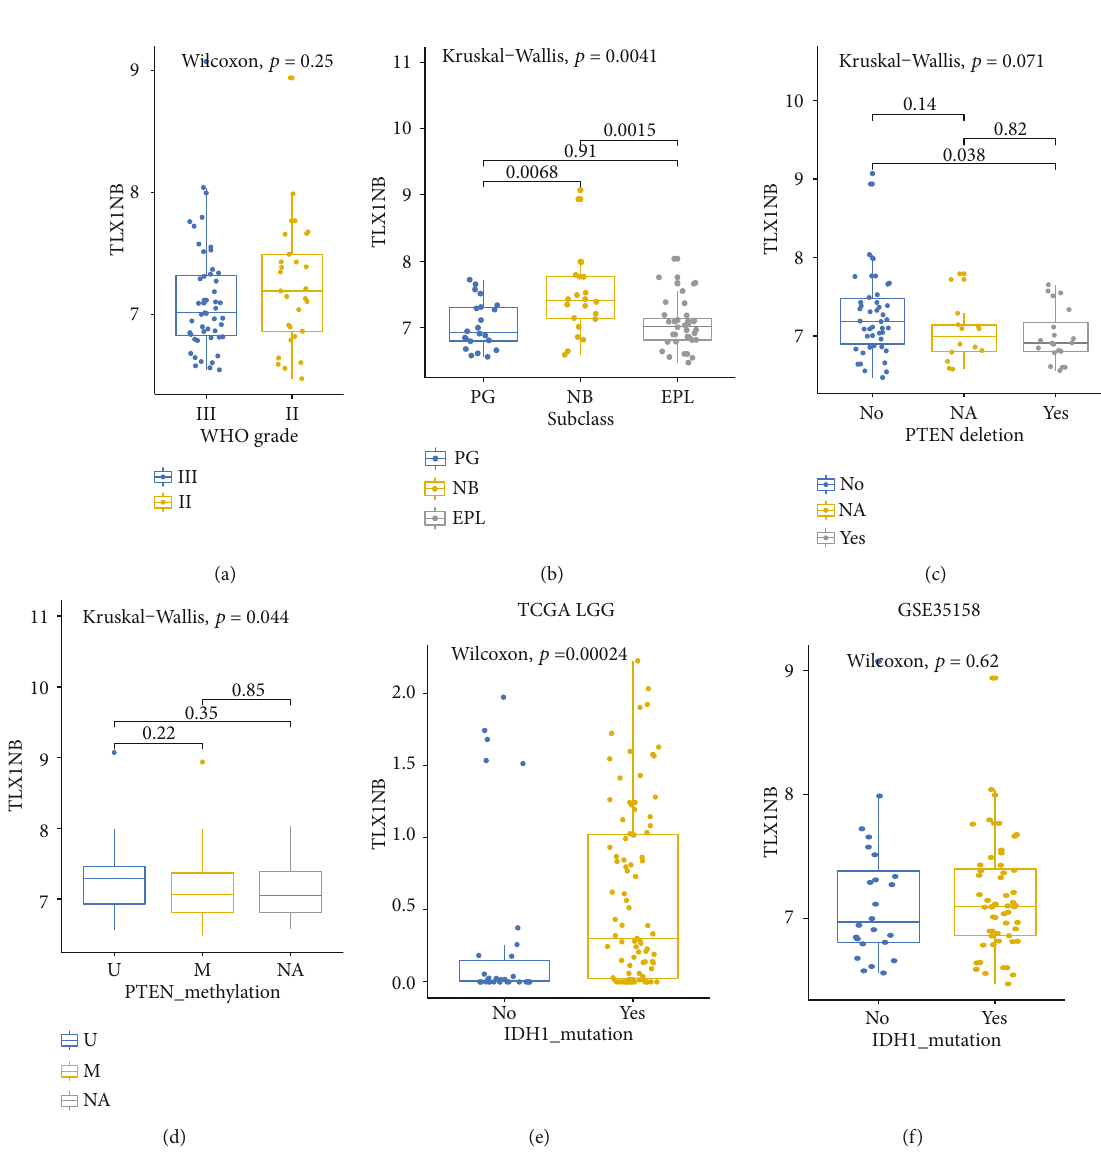
Figure 4: TLX1NB distribution in di ff erent subsets. (a) TLX1NB distribution between grade II and III LGG. A p value < 0.05 was selected as the signi fi cance threshold. (b) High expression of TLX1NB in the NB group compared with PG and EPL. A p value < 0.05 was selected as the signi fi cance threshold. NB: neuroblastic; PG: preglioblastoma; EPL: early progenitor-like. (c) Low expression of TLX1NB in the PTEN deletion group. A p value < 0.05 was selected as the signi fi cance threshold. (d) No di ff erence for TLX1NB between PTEN methylation and unmethylation group. A p value < 0.05 was selected as the signi fi cance threshold. (e) High expression of TLX1NB in the IDH1 mutation group in the TCGA dataset. A p value < 0.05 was selected as the signi fi cance threshold. (f) No di ff erence for TLX1NB between IDH1 mutation and wildtype group in GSE35158. A p value < 0.05 was selected as the signi fi cance (Figure 4(d)). TLX1NB was signi fi cantly upregulated in the IDH mutation group in the TCGA dataset (Figure 4(e)); however, no di ff erence was observed in the GSE35158 dataset (Figure 4(f)). The result for IDH mutation was controversial. expression of TLX1NB in the PTEN deletion group (Figure 4(c), p = 0 : 038 , Kruskal – Wallis test). To explore the relationship between TLX1NB , PTEN promoter methylation, and IDH deletion, we analyzed TLX1NB expression and PTEN promoter in GSE35158 and TLX1NB expression and IDH mutation in TCGA and GSE35158. No signi fi cant change of TLX1NB expression was observed between PTEN methylation group and nonmethylation group in GSE35158